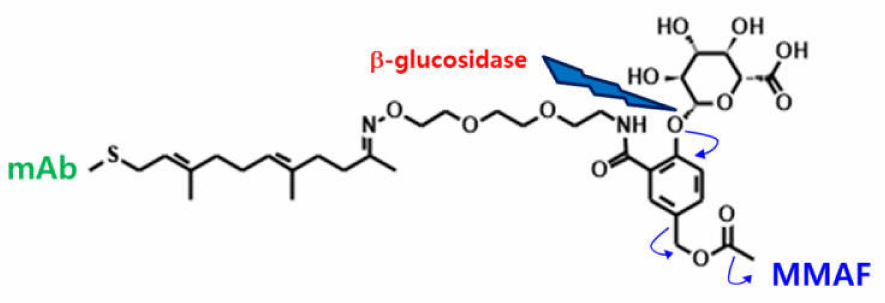
Figure 7. Scheme of the cleavage mechanism of site-specific enzymatic cleavage of